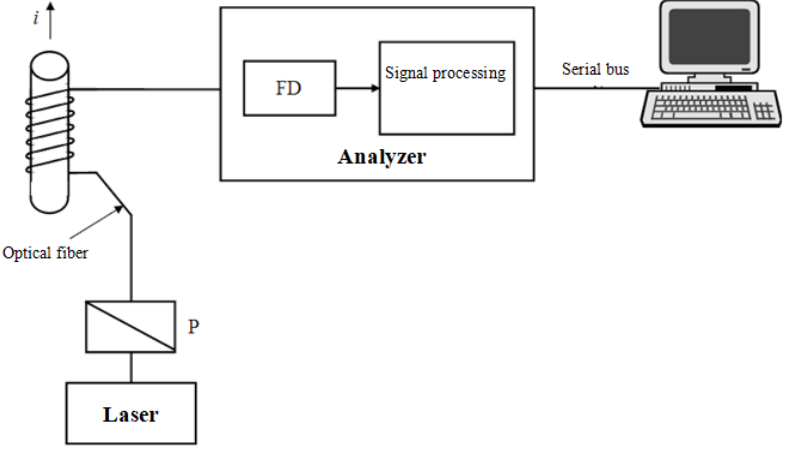
Figure 1. Block diagram of the polarimetric current strength probe with the fiber optic measuring coil: P: polarizer setting the initial and constant polarization; FD: photodetector in the polarization analyzer [19].